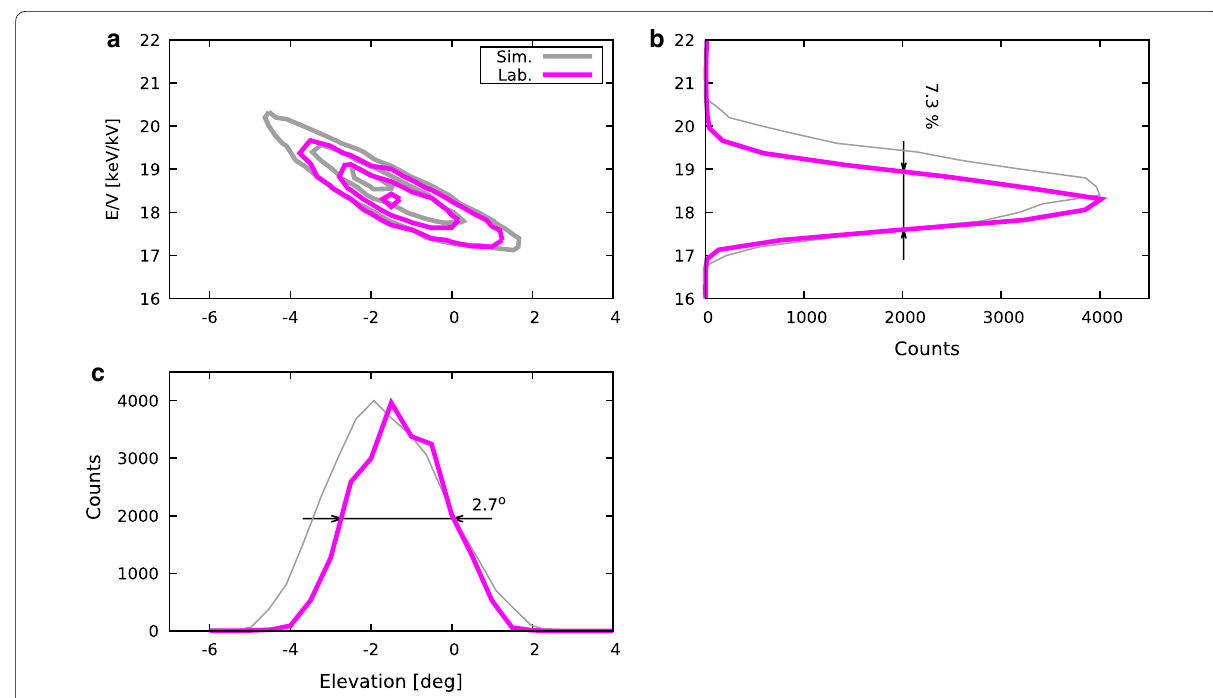
Fig. 5 Measured (Lab.) and calculated (Sim.) energy–angular responses of the azimuthal channel 0 for the 40-keV proton beam